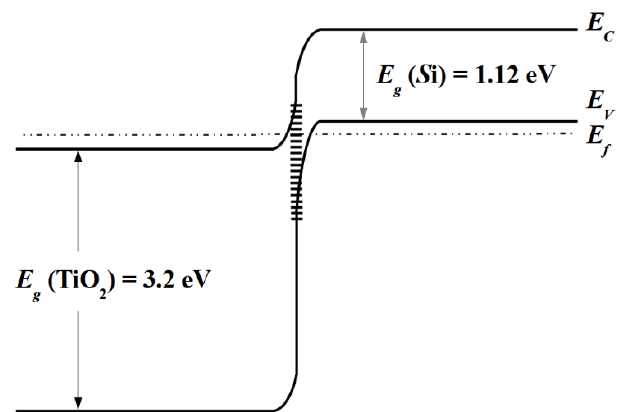
Figure 6. Energy band diagram of n + –TiO 2 / p + -Si tunnel heterojunction in an equilibrium